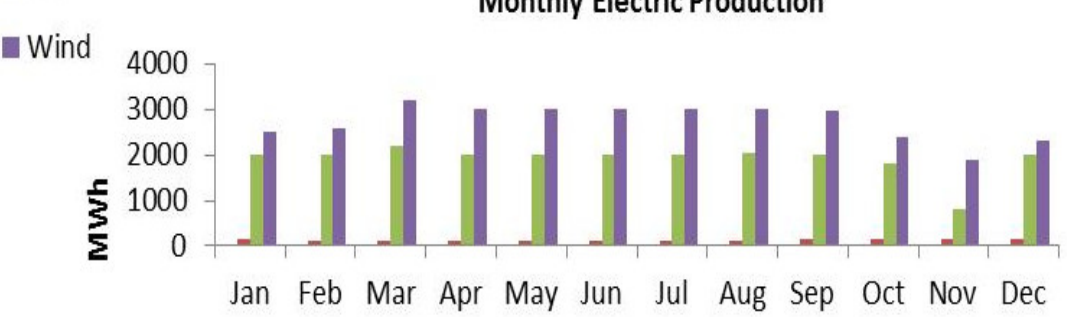
Figure 21. Monthly average electric production. Table 6. The yearly emissions of the suggested system.